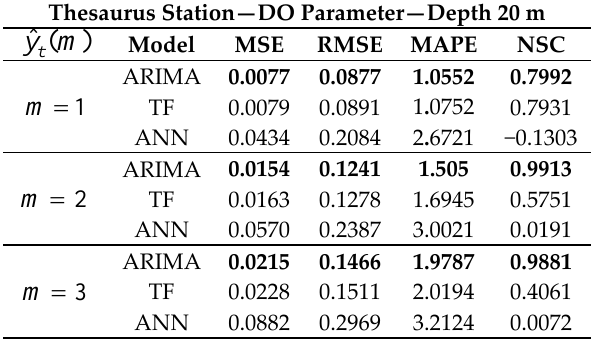
Table 2. Statistical parameters for comparison of observed and predicted values using ARIMA, TF and ANN models and m = 1, 2 and 3 (20 m depth).